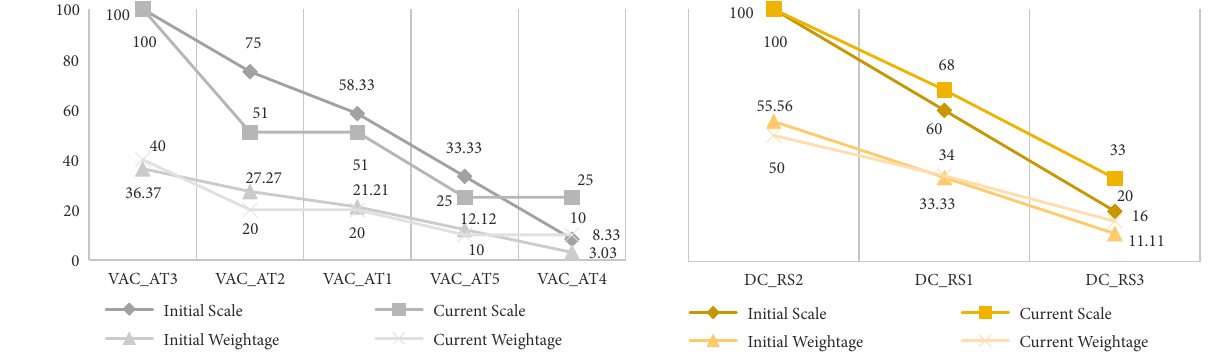
Figure A17. Model modification for sub-criteria of AT Figure A18. Model modification for sub-criteria of RS